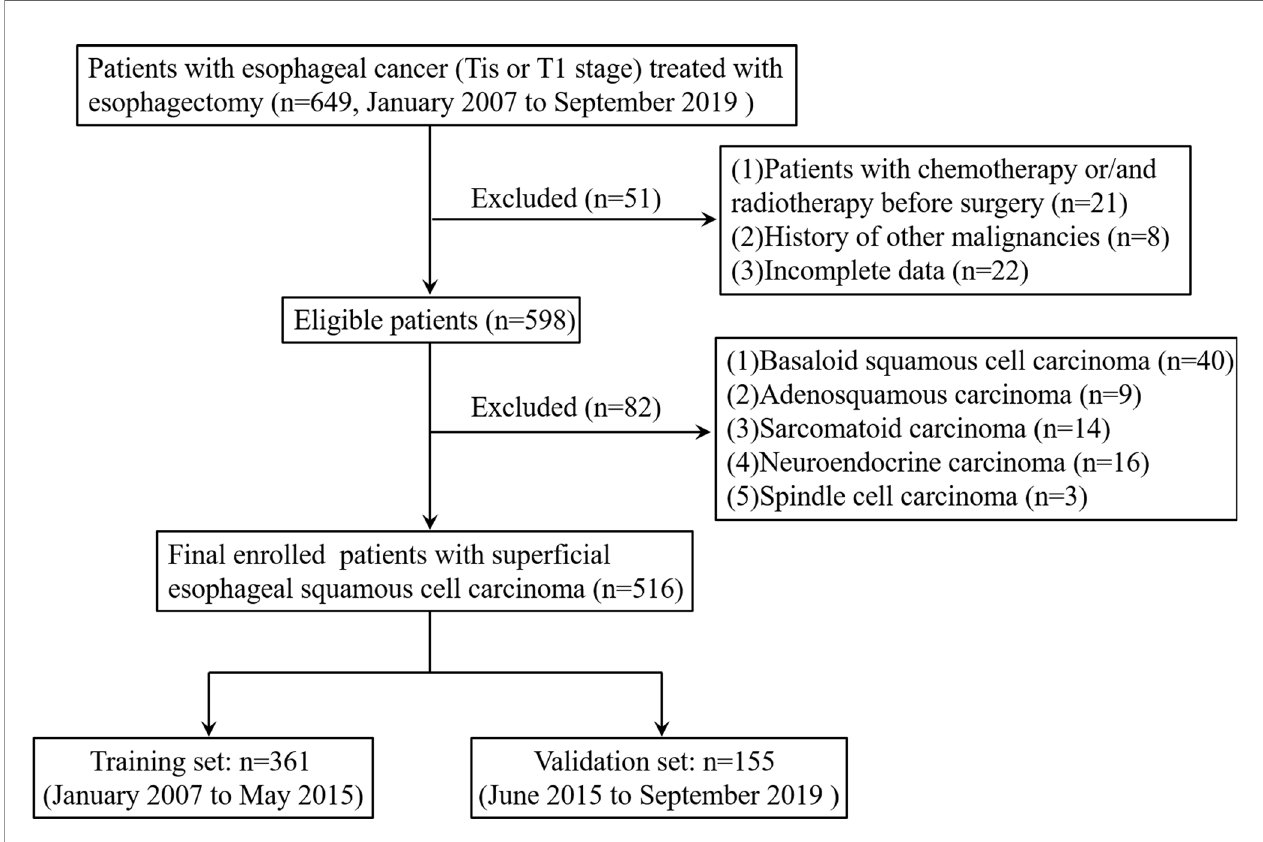
FIGURE 1 | Flowchart of patients included in the